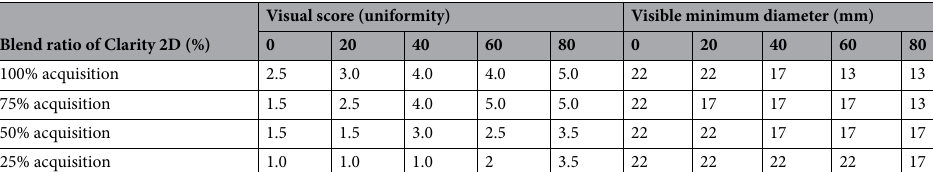
Visual score (uniformity) Visible minimum diameter Blend ratio of Clarity 2D (%)